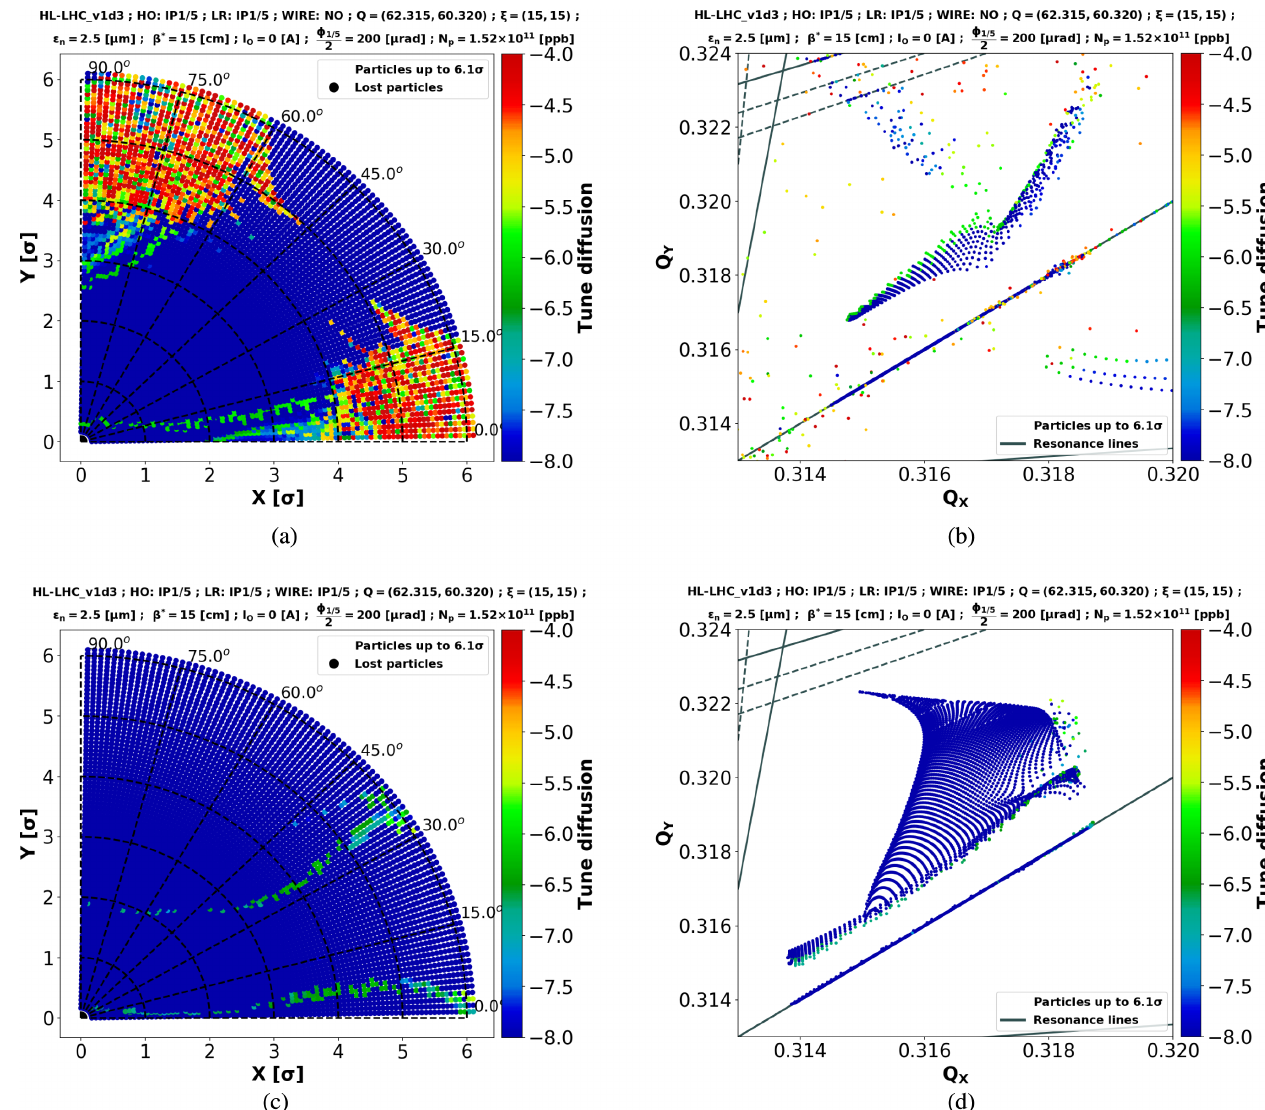
FIG. 7. HL-LHC at the end of luminosity leveling with half crossing angle at IP1 and IP5 200 μ rad and N p ¼ 1 . 52 × 10 11 ppb. (a) and (c) for particles up to 6 . 1 σ the tune diffusion of the cases without and with wire compensator, respectively. (b) and (d) for particles up to 6 . 1 σ the footprint and the tune diffusion of the cases without and with wire compensator,